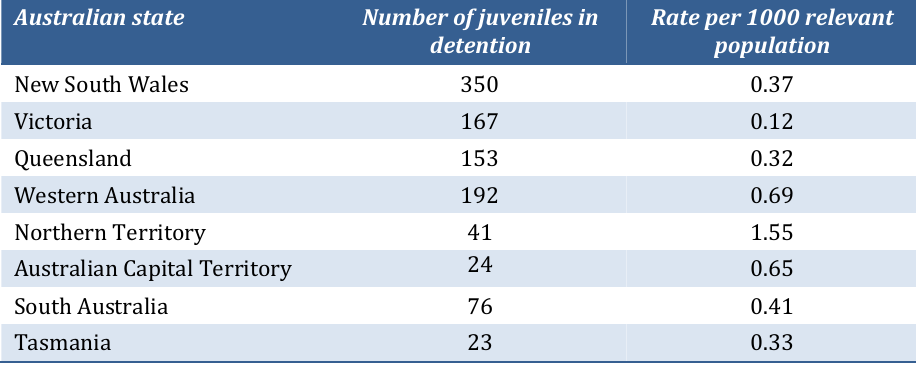
Table 4: Youth confinement in Australian states, 2012 Australian state Number of juveniles in